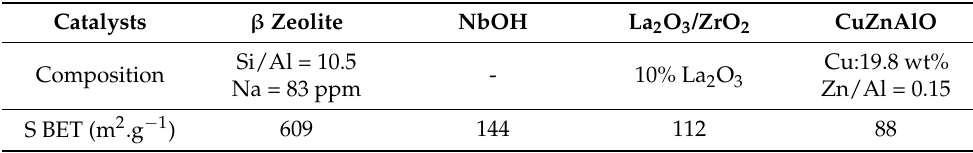
Table 5. Catalysts’ composition and BET surface